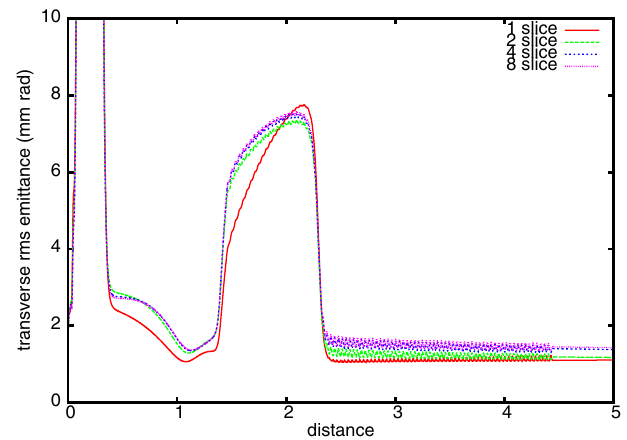
FIG. 11. (Color) Transverse normalized rms emittance as a function of distance using one slice, two slice, four slice, and eight slice model of the